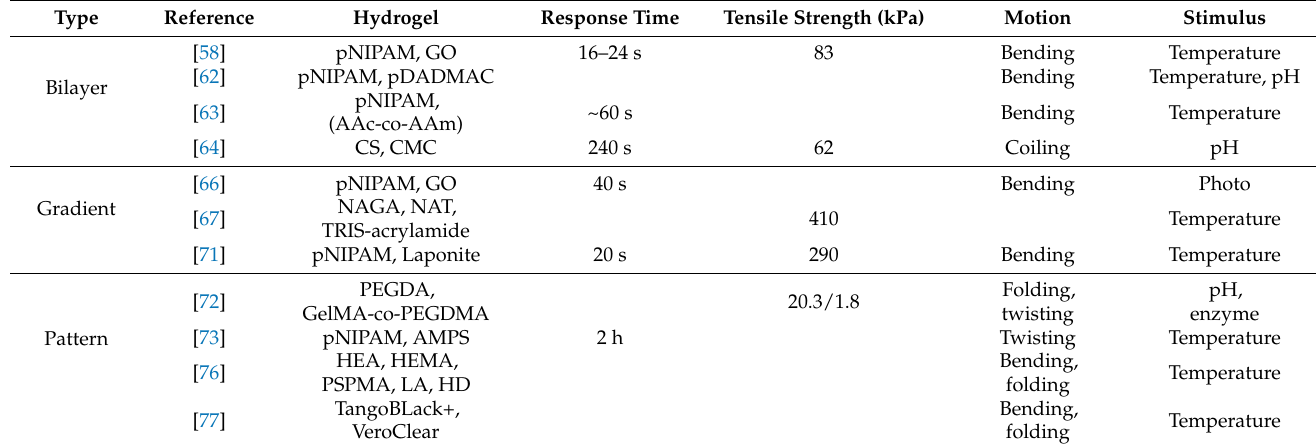
Table 1. Comparison of three types of hydrogel soft